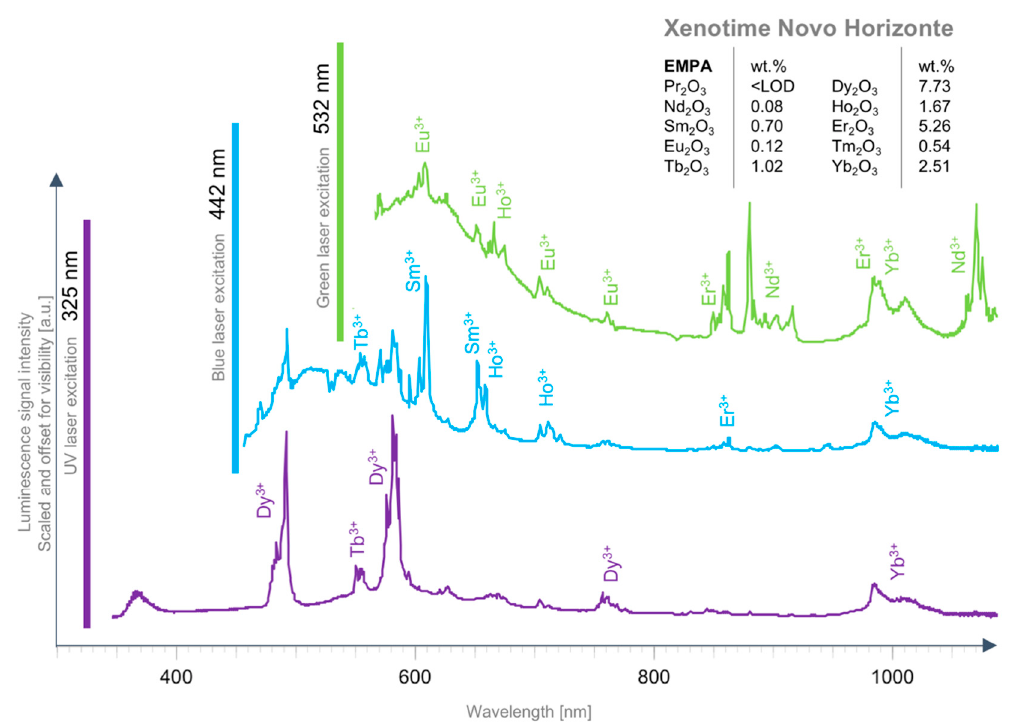
Figure 5. REE and matrix emission variability in a xenotime sample are displayed as a function of three different laser excitation wavelengths. Selected REE emissions have been labelled according to reference feature positions (see text, Section 4.2.).